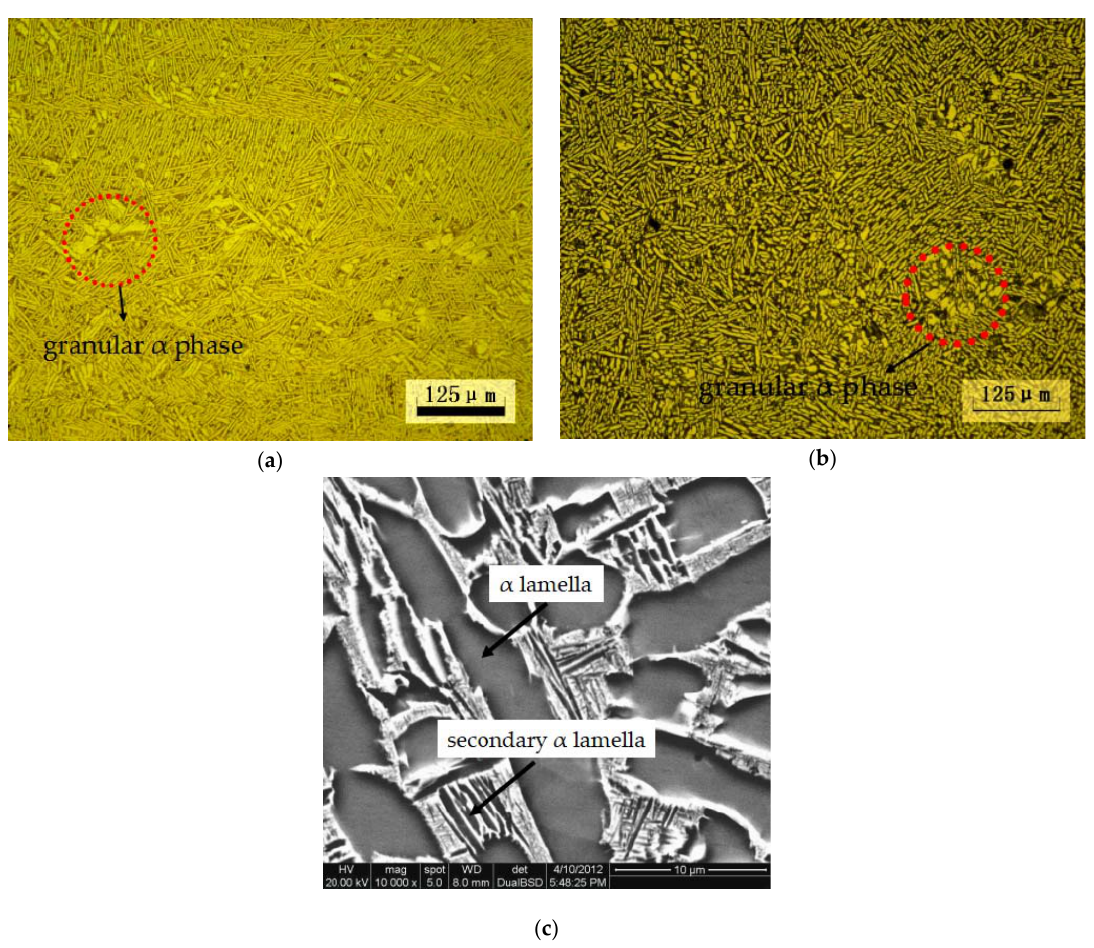
Figure 1. Basketweave microstructures of TC21 titanium alloy: ( a ) basketweave size of 60 μ m (OM); ( b ) basketweave size of 40 μ m (OM) and ( c ) a double lamellar basketweave microstructure (SEM).